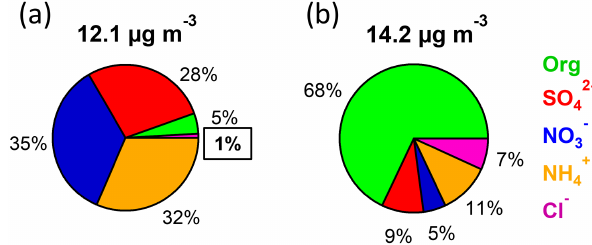
Figure 12. Average chemical composition of the difference between ground level and 260m (a) before APEC and (b) during APEC. The “1%” in the box indicates a lower concentration of chloride at the ground site compared to at 260m.